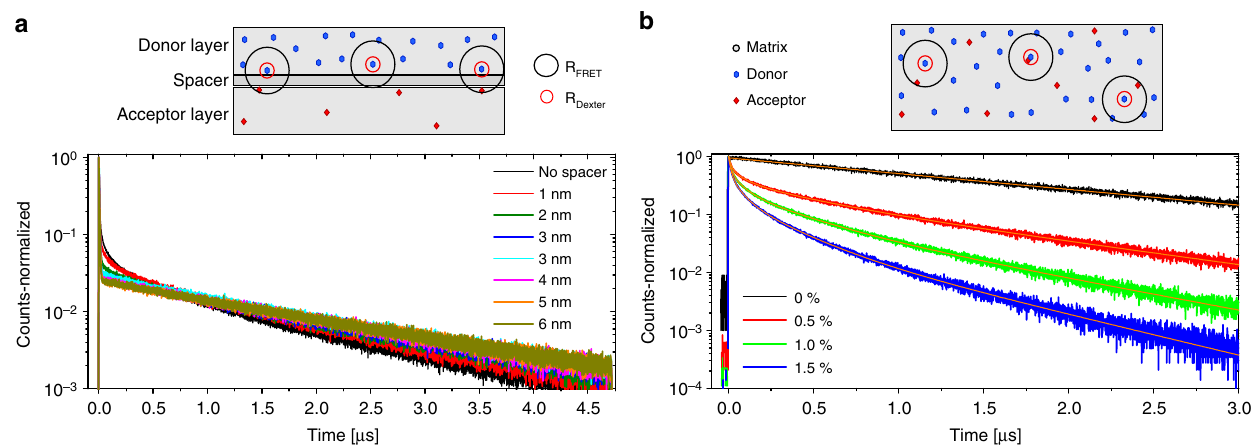
Fig. 3 Time-resolved photoluminescent experiments. All samples were excited at 375 nm to suppress direct acceptor excitation. a Sketch and TRPL-data of bilayer samples. The thickness of the matrix spacer layer, which separates the donor from the acceptor layer, was varied from 0 to 6 nm. Förster-radius and Dexter-radius are depicted (not to scale) as black and red circles around the donor molecules. The inset shows a zoom-in to illustrate the increase of counts. b Sketch and TRPL-spectra of mixed layers. The A concentration was gradually increased from 0% to 1.5%. The decays were fi tted with a multi- exponential fi t (red lines) to derive the mean (intensity-weighted) radiative decay